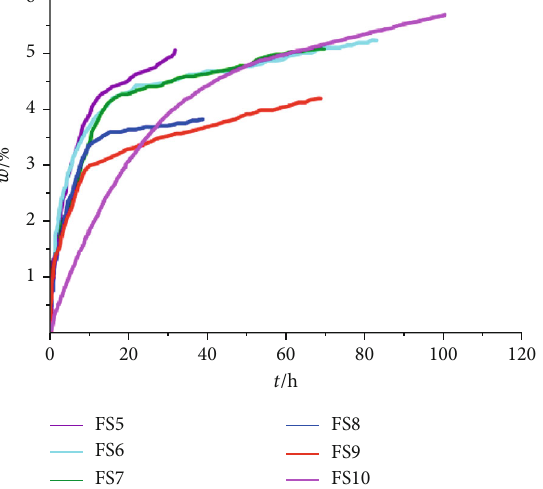
Figure 23: Curve of water absorption rate of the siltstone samples.